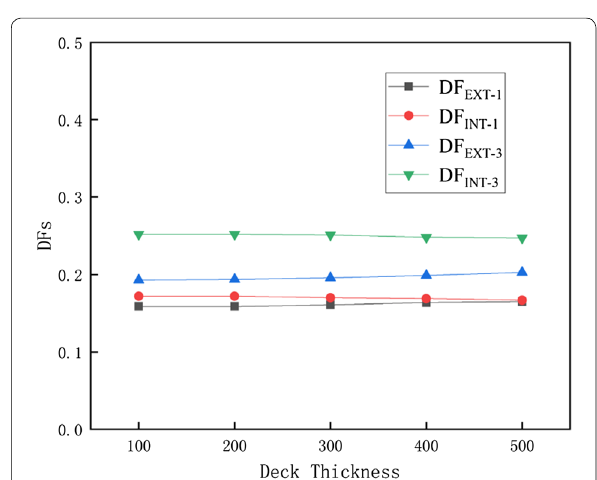
Fig. 17 DFs for bridge deck thickness